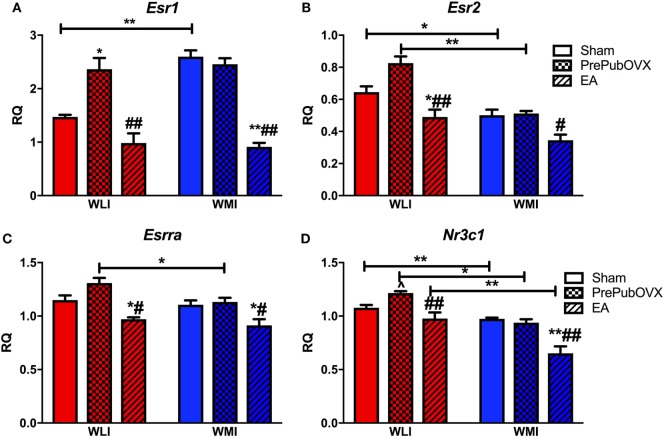
Lack of ovarian hormones before puberty [early adolescents (EA)] or by PrePubOVX affects hippocampal expression of estrogen and glucocorticoid receptors. Gene expression levels as measured by RT-qPCR. (A) Estrogen receptor alpha (Esr1). (B) Estrogen receptor beta (Esr2). (C) Estrogen-related receptor alpha (Esrra), and (D) glucocorticoid receptor (Nr3c1). Relative quantification (RQ) are Ct values normalized to GAPDH, and then to a universal calibrator calculated using the −ΔΔCt method. **p < 0.01 and *p < 0.05 are within strain group comparisons compared with Sham animals, ##p < 0.01 and #p < 0.05 are within strain compared with PrePubOVX animals, lines marked by **p < 0.01 and *p < 0.05 are for strain comparisons, all by Bonferroni-corrected post hoc analyses. ^p < 0.05 by Student’s t-test, as hypothesis testing between two groups, when ANOVA is significant or a trend (p < 0.1). Data are presented as mean ± SEM.